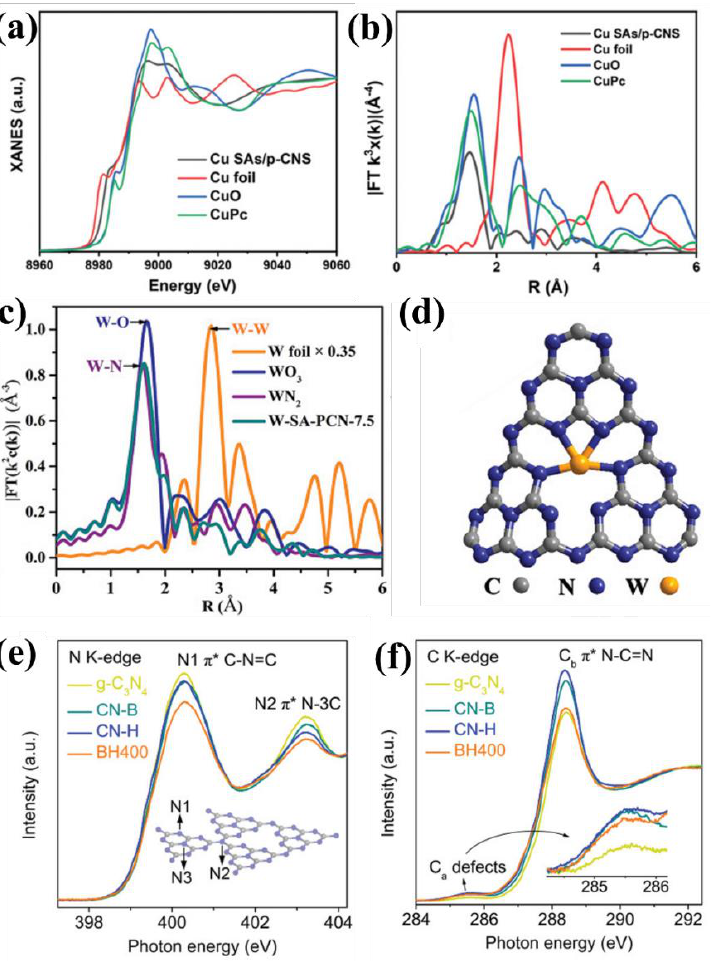
Figure 12. ( a ) XANES and ( b ) EXAFS spectra of Cu k-edge of Cu SAs/p-CNS, Cu foil, CuO and CuPc [99]. ( c ) FT-EXAFS curves of W-SA-PCN-7.5 and the references. ( d ) Atomic structure model of W-SA-PCN-7.5 [100]. ( e ) N K-edge and ( f ) C K-edge XANES spectra of g–C 3 N 4 , CN–B, CN–H and BH400